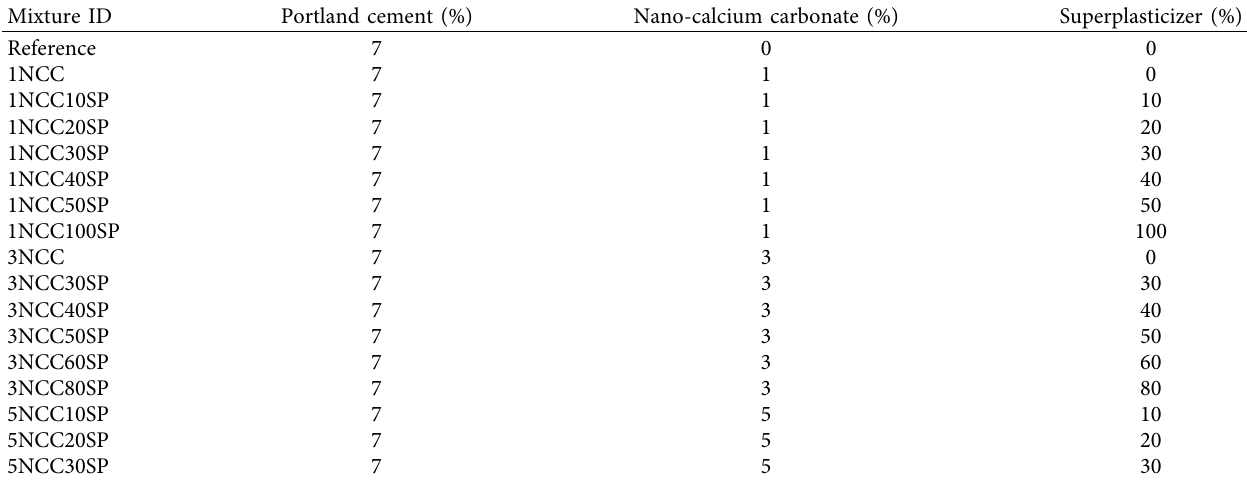
Table 5: Mixing design for all backfill samples containing nano-calcium carbonate.